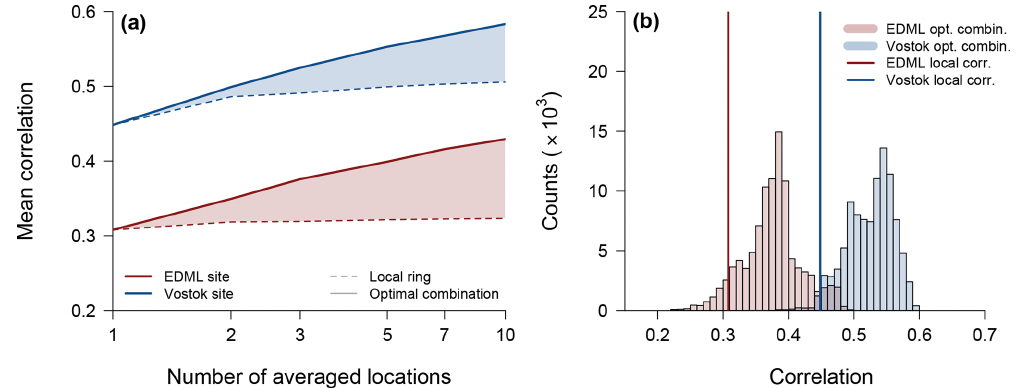
Figure 8. Gain in correlation and risk of adverse sampling. ( a ) The average correlation with the target temperature at the EDML (red) and Vostok (blue) sites depending on the number of locations, N (cid:96) , used for averaging the δ 18 O (pw) time series. Sampling is performed either locally from the innermost ring only (dashed lines) or from all possible individual combinations of locations for the respective optimal ring combination determined for each N (cid:96) (solid lines). Compared to the local samples, which show virtually no or only a small increase with the number of sampled locations, the correlation increases markedly with N (cid:96) when sampling from the optimal rings, as highlighted by the shaded area. ( b ) Histogram of individual correlations for sampling from the optimal ring combination when averaging N (cid:96) = 3 locations compared to the correlation (vertical lines) for sampling from the innermost ring only, displayed for the EDML (red) and Vostok (blue) target sites. In both cases, the correlation is higher than the local value for more than 93% of the optimal ring combination